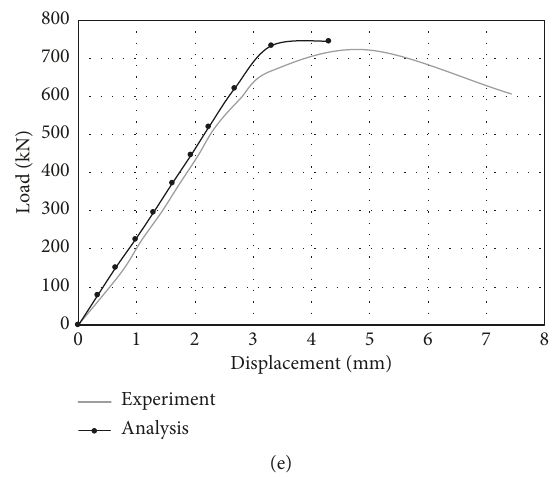
Figure 6: Comparison of finite element analysis result and experiment result. (a) Finite element model. (b) Dimension of the specimen. (c) Test setup. (d) Failure of the specimen. (e) Comparison of the load-displacement